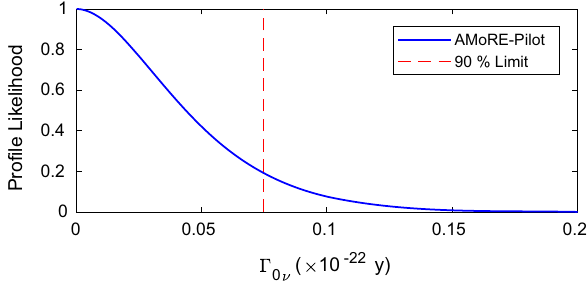
Fig. 8 Profile likelihood function with respect to the decay rate, (cid:14) 0 ν . The dashed red line is the limit corresponding to 90% confidence level